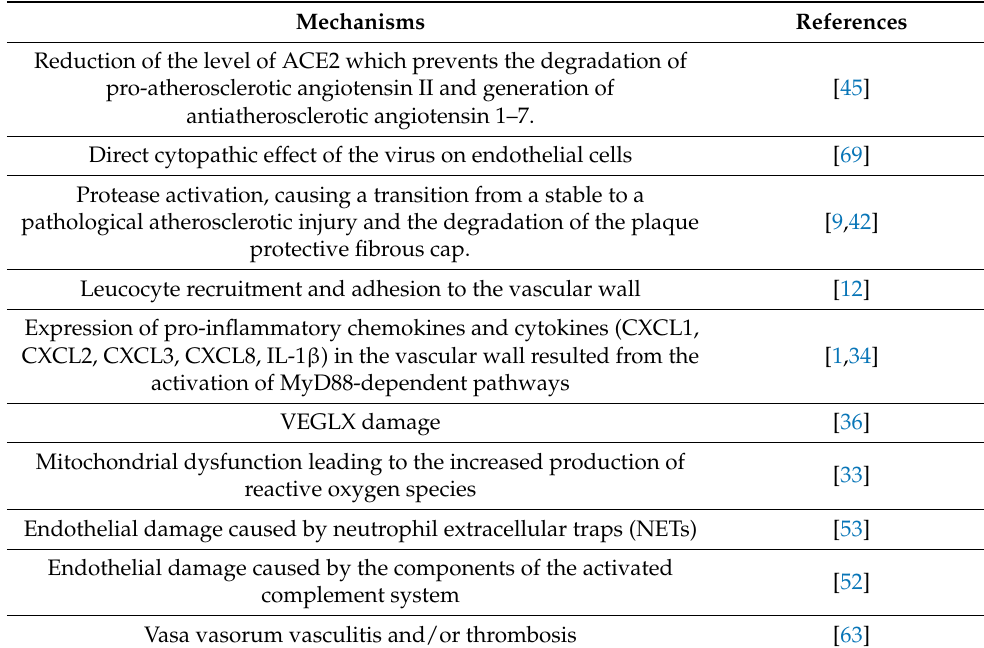
Table 2. Mechanisms of COVID-19’s contribution to atheroma formation and development.